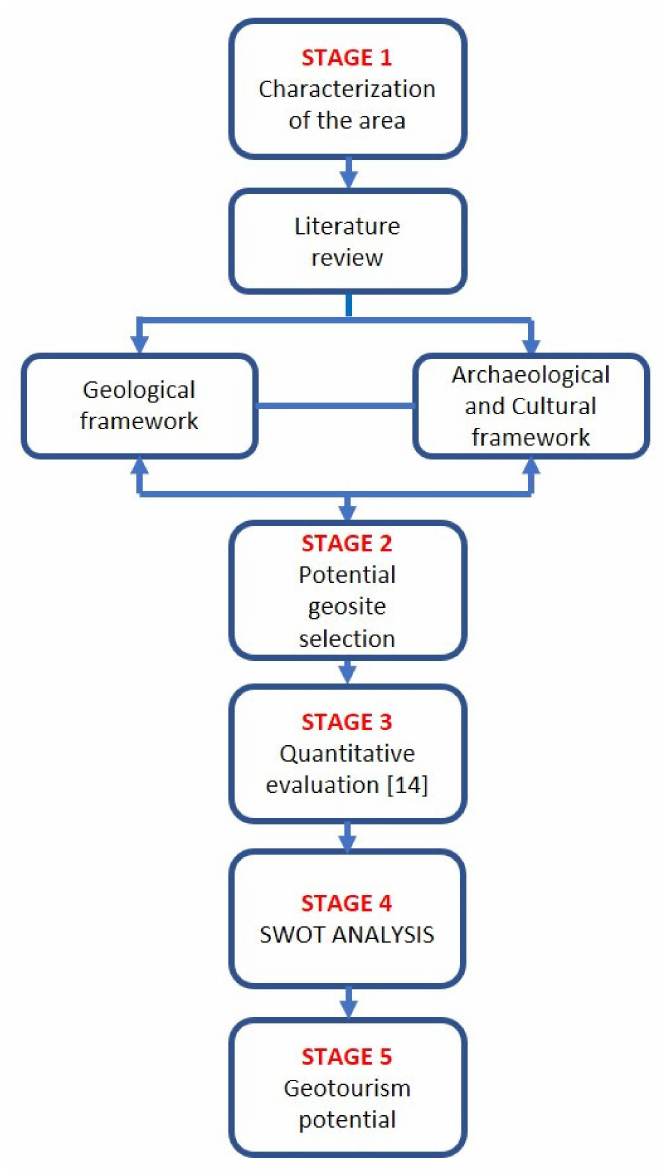
Figure 5. Methodology flow chart followed in this